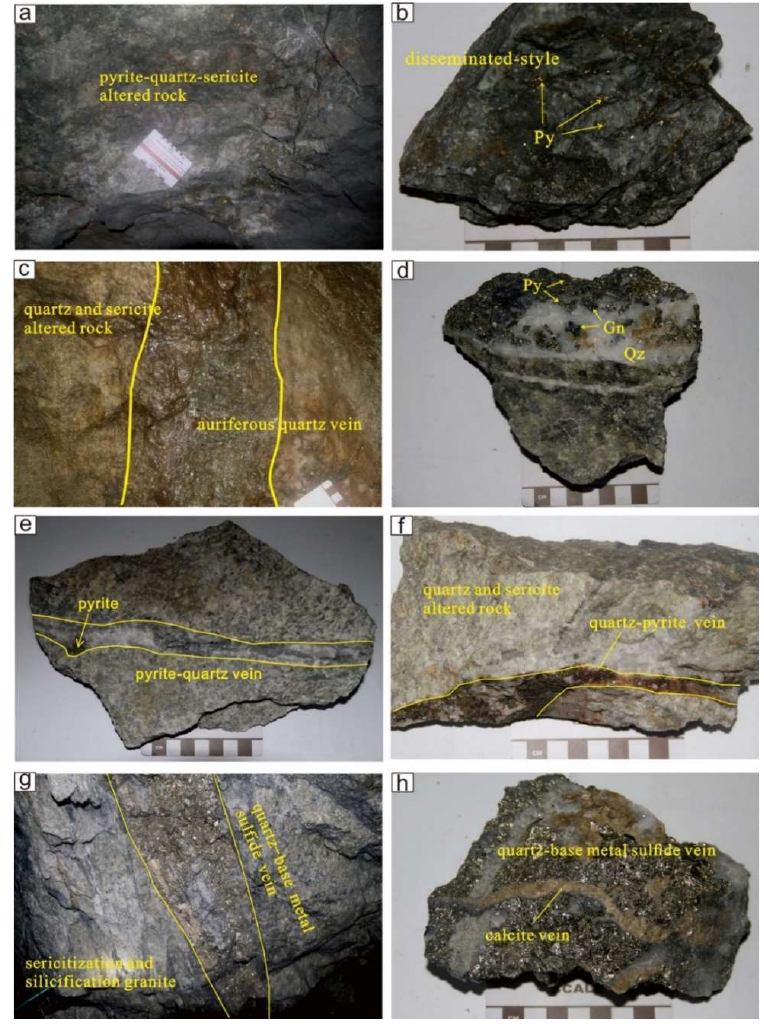
Figure 3. Field photographs demonstrating major geologic bodies with cross-cutting relationships and different mineral assemblages. ( a , b ) Disseminated-style ore of stage 1 (early stage); ( c ) auriferous quartz vein of stage 2 (main stage) in sericitized and silicified granite; ( d ) auriferous quartz vein-style ore of stage 3 (main stage); ( e ) the early-stage milky white quartz vein with disseminated pyrite; ( f ) main stage quartz–pyrite veinlet cut across the early-stage sericite–quartz altered rock; ( g ) quartz–base–metal–sulfide vein; ( h ) late stage (stage 4) quartz–calcite veins cutting the quartz–base–metal–sulfide vein. Qz—quartz; Gn—galena;